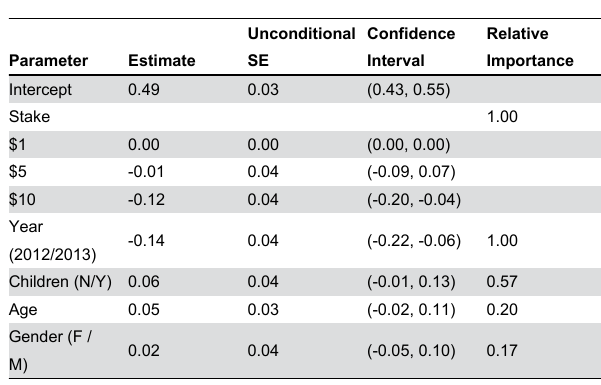
Table 3. Estimates, unconditional standard errors, confidence intervals and relative importance for parameters included in the top models for players from